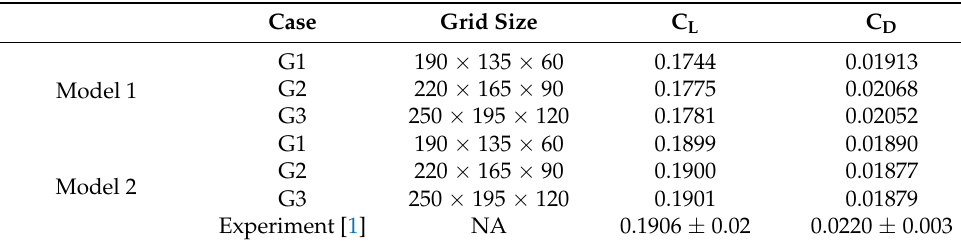
Table 1. Grid-sensitivity analysis for α = 4 ◦ . Case Grid Size C